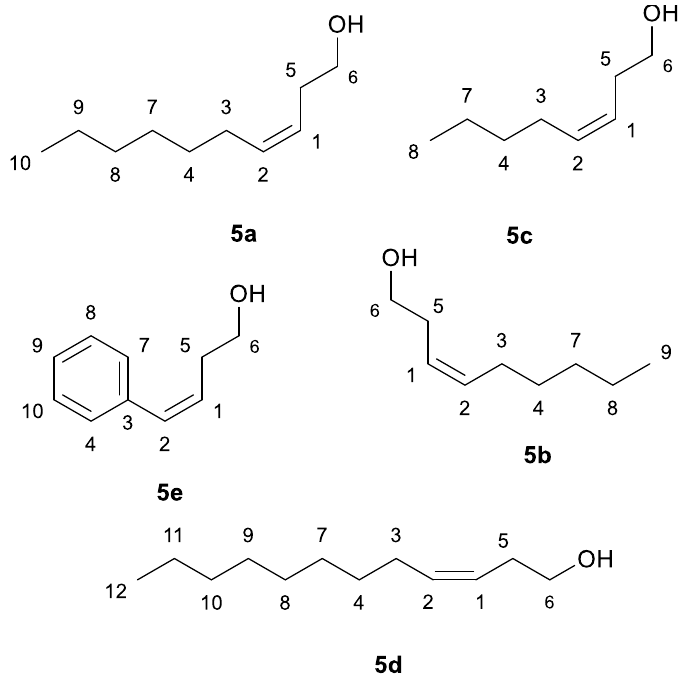
Figure 2. The numbering of atoms in the 13 C- and 1 H-NMR spectra of the compounds 5a – e .